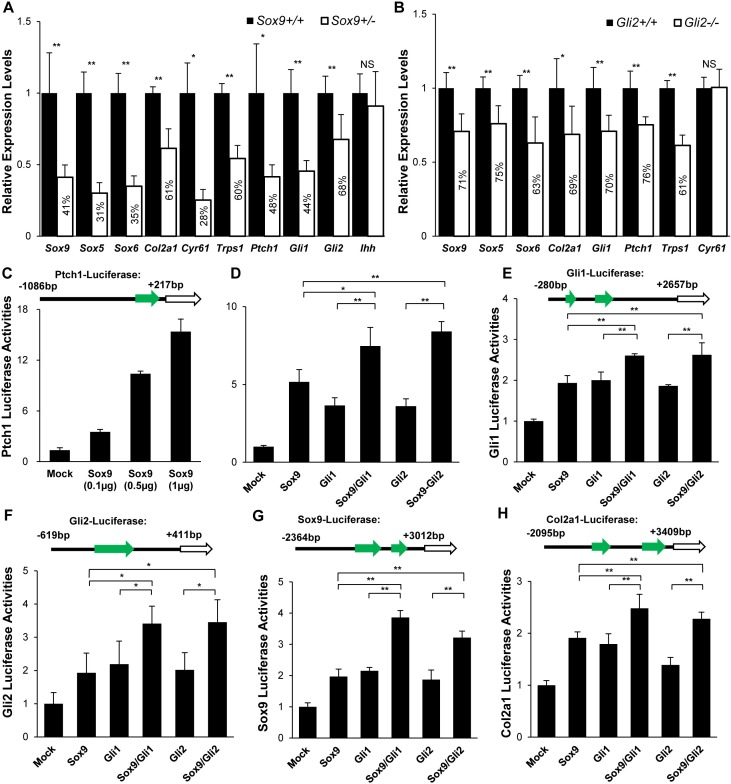
Functional validation of SOX9 and GLI cooperation.(A) Relative expression levels of SOX9-GLI common target genes in Sox9+/+ and Sox9+/- limb chondrocytes (E13.5). (B) Relative expression levels of SOX9-GLI common target genes in Gli2+/+ and Gli2-/- limb chondrocytes (E13.5). Gapdh was used as the endogenous control. The error bar represents the standard deviation of the relative expression level of each gene in independent triplicate. (C) SOX9 activated the expression of Ptch1 promoter in a dosage dependent manner in transiently transfected ATDC5 cells. (D-H) SOX9 increased GLI-dependent activation of Ptch1, Gli1, Gli2, Sox9 and Col2a1 regulatory elements in transiently transfected ATDC5 cells. Expression plasmids for Sox9, Gli1, Gli2 and their combination were cotransfected as indicated below the bars. Equal amounts of expression plasmids were used for each well. **: p-value < 0.01; *: p-value < 0.05; NS: Non-significant.